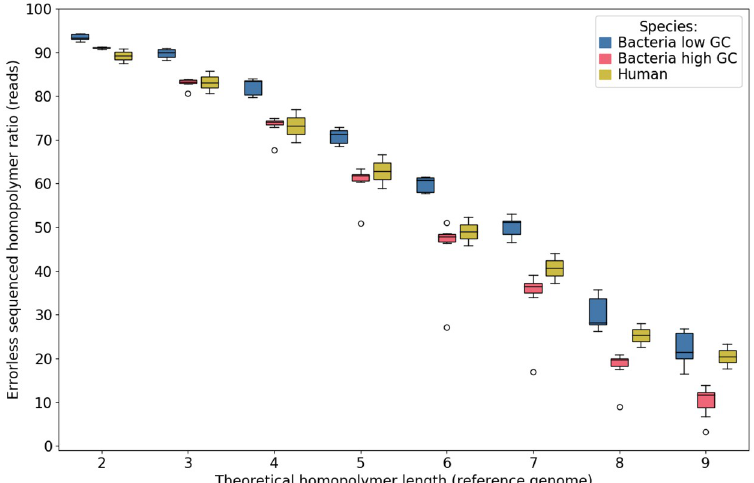
Fig 8. Ratio of well-sequenced homopolymers as a function of their reference length. Results are pooled into three categories: low GC (blue) and high GC (red) bacterial species, and human data